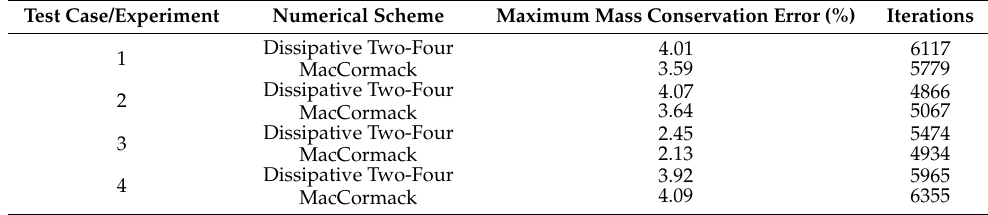
Table 3. Mass balance error and number of iterations for